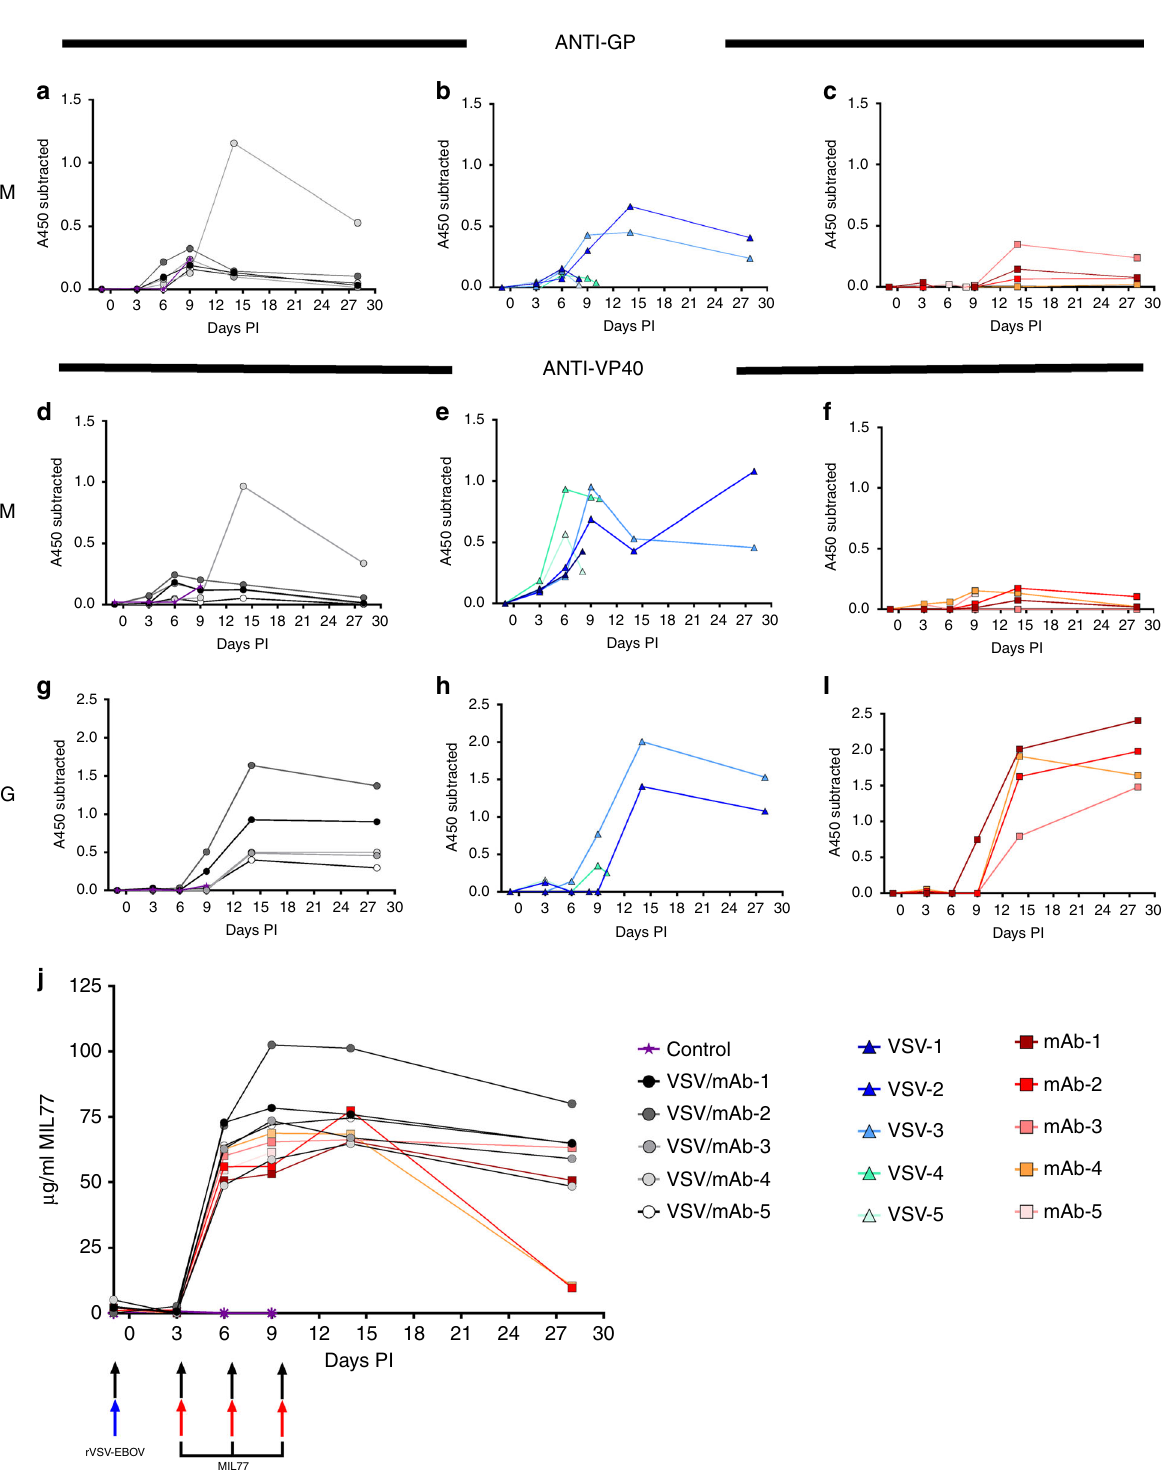
Fig. 4 Circulating host and therapeutic antibodies in EBOV-challenged and treated rhesus macaques. Circulating anti-GP IgM from rVSV-EBOV + MIL77 ( a ), rVSV-EBOV ( b ), and MIL77 ( c ) groups. Circulating anti-VP40 IgM from rVSV-EBOV + MIL77 ( d ), rVSV-EBOV ( e ), and MIL77 ( f ) groups. Circulating anti-VP40 IgG from rVSV-EBOV + MIL77 ( g ), rVSV-EBOV ( h ), and MIL77 ( i ) groups. ELISA data are represented as mean technical replicates ( n = 2) where change in absorbances at 450 nM subtracted from baseline at day − 1 ( a – i ). Circulating MIL77 concentrations for the rVSV-EBOV + MIL77 and MIL77 groups are represented over time ( j ). rVSV-EBOV + MIL77 ( n = 5), rVSV-EBOV ( n = 5), MIL77 ( n = 5), control ( n = 1). Signi fi cance of concentration differences between rVSV-EBOV + MIL77 and MIL77 only groups (*** p < 0.001) were determined with two-tailed t -tests using Holm – Sidak correction for multiple comparisons. Source data are provided as a Source data fi